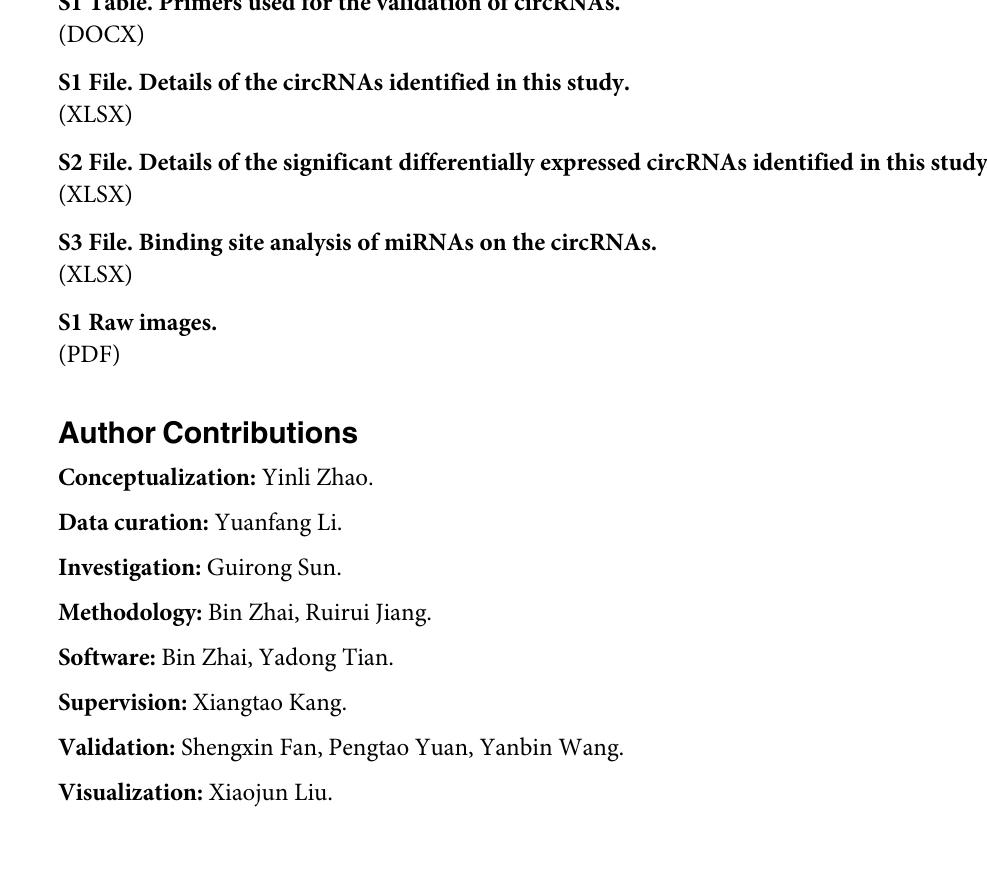
S1 Fig. Quality evaluation and processing of sequencing data. (A) The sequencing error rate of each base position. (B) The content of each base during the sequencing process. (C) The proportion of different types of raw data. (D) Classification of mapped reads in 12 libraries. (TIF) S2 Fig. Characteristics of the identified circRNAs. (A) Length distribution. (B) The distribu- tion of circRNAs in different chromosomes. (TIF) S3 Fig. Dynamic expression profile of the identified circRNAs. (TIF) S4 Fig. CircRNA-miRNA-gene interaction network contains five pathways related to cell proliferation and differentiation. The ellipse, triangle and box nodes represent DE miRNAs, DE circRNAs, and DE mRNAs, respectively. Pink indicates upregulation, and blue indicates downregulation. The five pathways are the Wnt signaling pathway, FoxO signaling pathway, p53 signaling pathway, TGF-beta signaling pathway and MAPK signaling pathway. (TIF) S5 Fig. CircRNA-miRNA-gene interaction network containing five cell junction-related pathways. The ellipse, triangle and box nodes represent miRNAs, circRNAs, mRNAs, respec- tively. Pink indicates upregulation, and blue indicates downregulation. The five pathways are cell adhesion molecules, focal adhesion, adherens junctions, tight junctions and gap junctions. (TIF) S1 Table. Primers used for the validation of circRNAs. (DOCX) S1 File. Details of the circRNAs identified in this study. (XLSX)